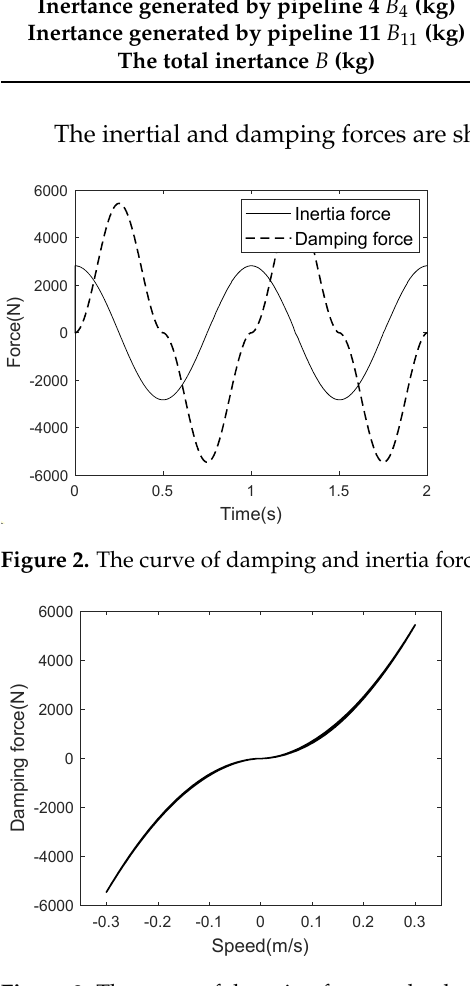
The inertial and damping forces are shown in Figure 2.